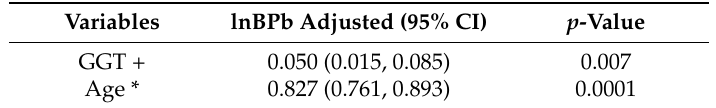
Table 8. Age and Clinical Factors and Tertiles of